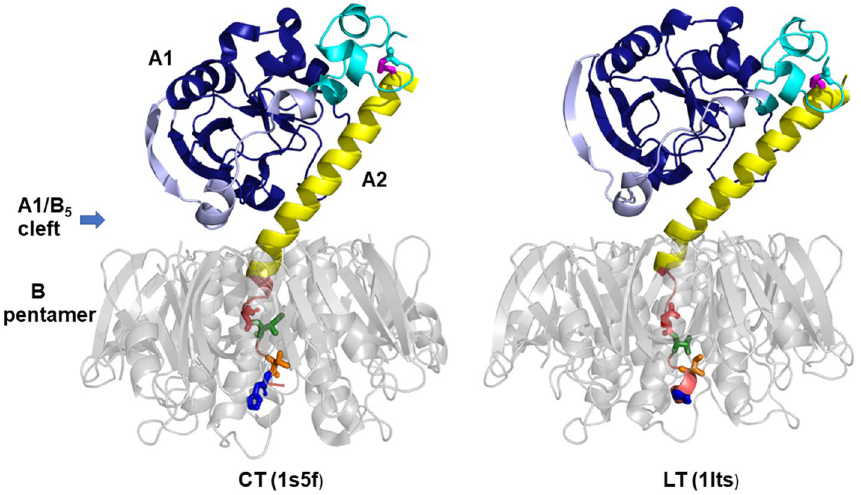
Figure 1. CT and LT structures. CT and LT are composed of a catalytic A1 subunit, a linker A2 subunit, and a cell-binding B pentamer (grey) that is organized as a ring-like structure from five identical subunits. The A1 subunit has three distinct subdomains: A1-1 (dark blue) spans residues 1–132 and represents the catalytic core of the protein, while A1-2 (light blue) spans residues 133–161 and wraps around the A1-1 subdomain to form an extended bridge with the A1-3 subdomain (cyan), a globular region that spans residues 162–192. A disulfide bond (magenta) connects cysteine 187 in the A1-3 subdomain with cysteine 199 in the N-terminal region of the A2 subunit. The major α-helical component of the A2 subunit (yellow) extends into the opening of the B pentamer, where it bends and threads through the pore in a largely unstructured state. The differences in CT and LT toxicity have been mapped to an 11 amino acid region of the non-catalytic A2 subunit that is located within the pore of the B pentamer (mauve). The four amino acid differences between CTA2 and LTA2 in this region are presented in stick format, with residues 229, 230, 232, and 233 colored red, green, orange, and blue, respectively. These residues are Asp, Ile, Thr, His in CT and Glu, Val, Ile, Tyr in LT. Images are generated by PyMOL 1.8.6.0 (Schrödinger,